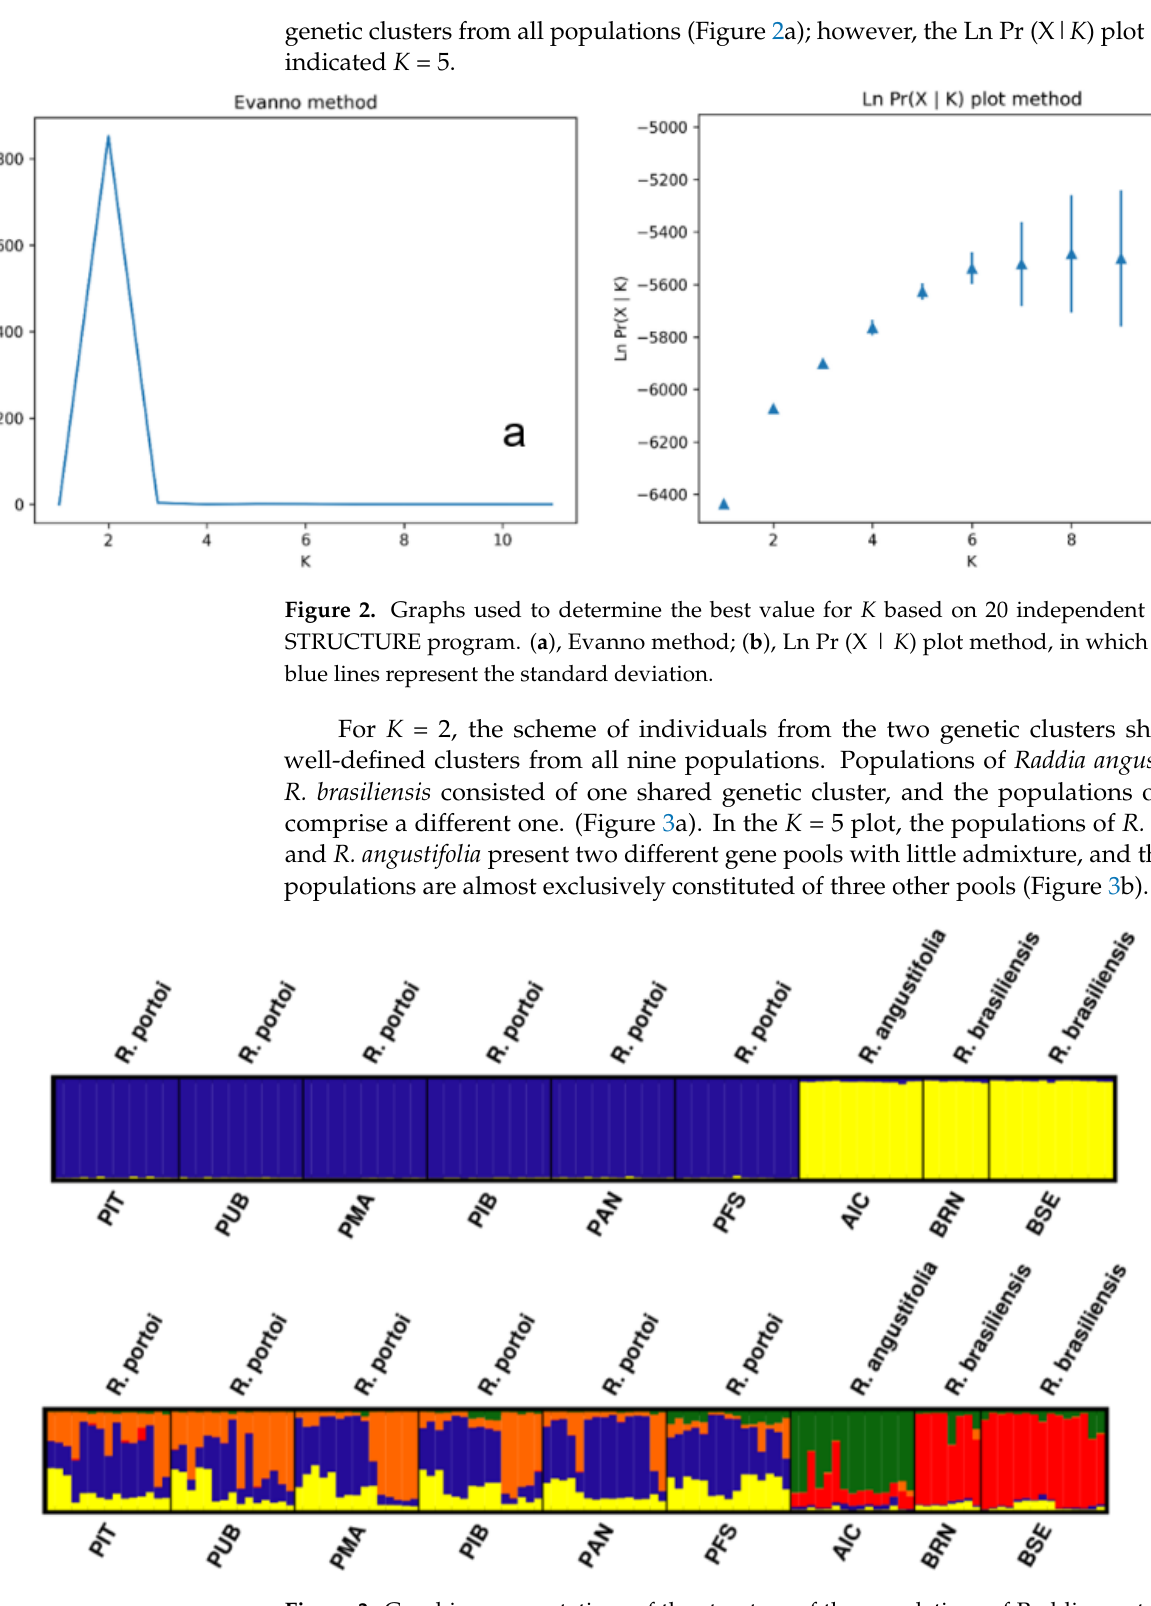
Figure 4. Graphic representations of the structure of the populations of Raddia created using the Gaussian cluster analysis on ISSR data, showing the proportion of gene pools in each population, with different colors representing different gene pools. Colors are consistent with Figure 3b. The AMOVA from all populations resulted in Φ PT = 0.20, equally divided into popu- lation divergence and region divergence ( p = 0.001 for both), with 80% of the total variation within populations (Table 2). Table 2. Analysis of molecular variance (AMOVA) for Raddia populations.